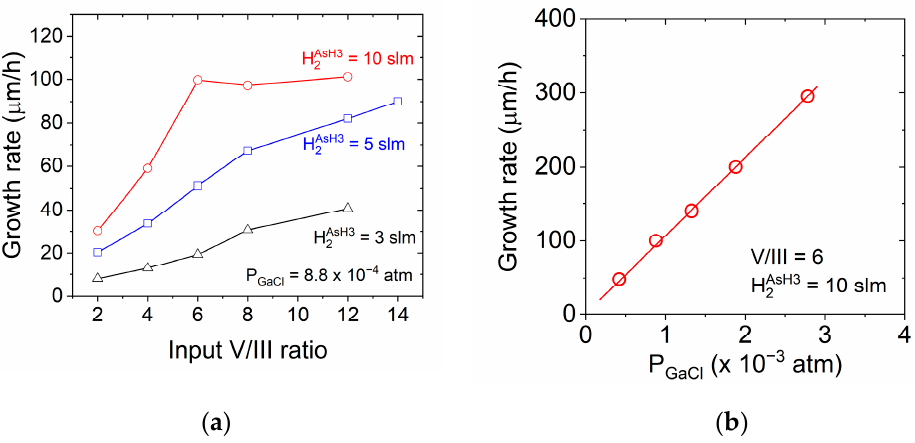
Figure 3. GaAs growth rates under different 𝐻 (cid:2870)(cid:3002)(cid:3046)(cid:3009)(cid:2871) flows as a function of ( a ) V/III ratio and ( b ) P GaCl .